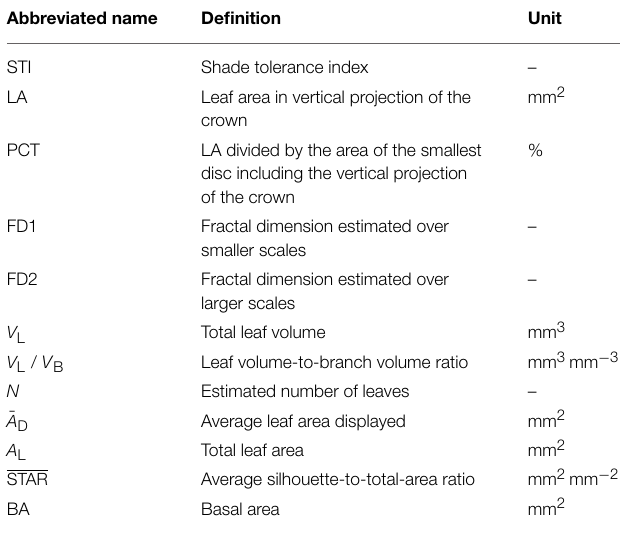
TABLE 1 | Abbreviated name of variables, their definition and